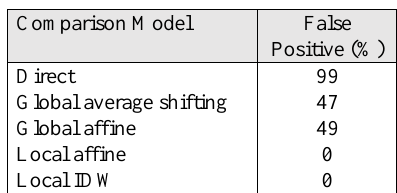
Figure 11. Identification of changes by the subtraction of DEMs after local affine transformation Increase in height above 5cm (green) Drop in height above 5cm (red). Figure 9. Shaded relief representation of the two DEMs with a zoomed are: before (right) 2 holes (green and orange) and flat land (blue), and after (left) 2 holes (green and blue) and covered hole (orange).